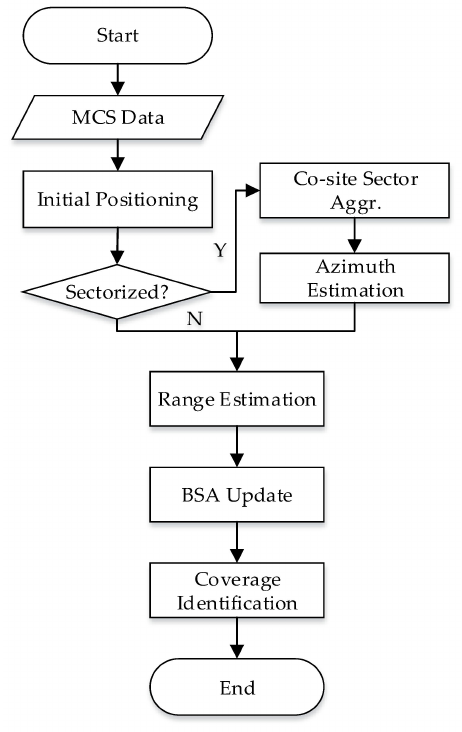
Figure 6. Flowchart of BSA detection algorithm.